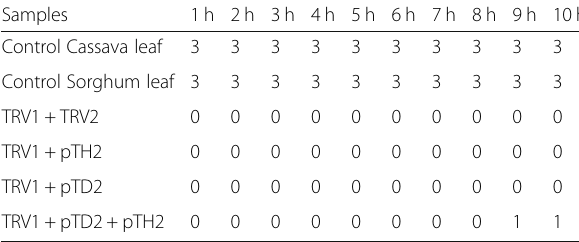
Table 4 The mean larvae weight post feeding at different durations on all the three feeding preference tests